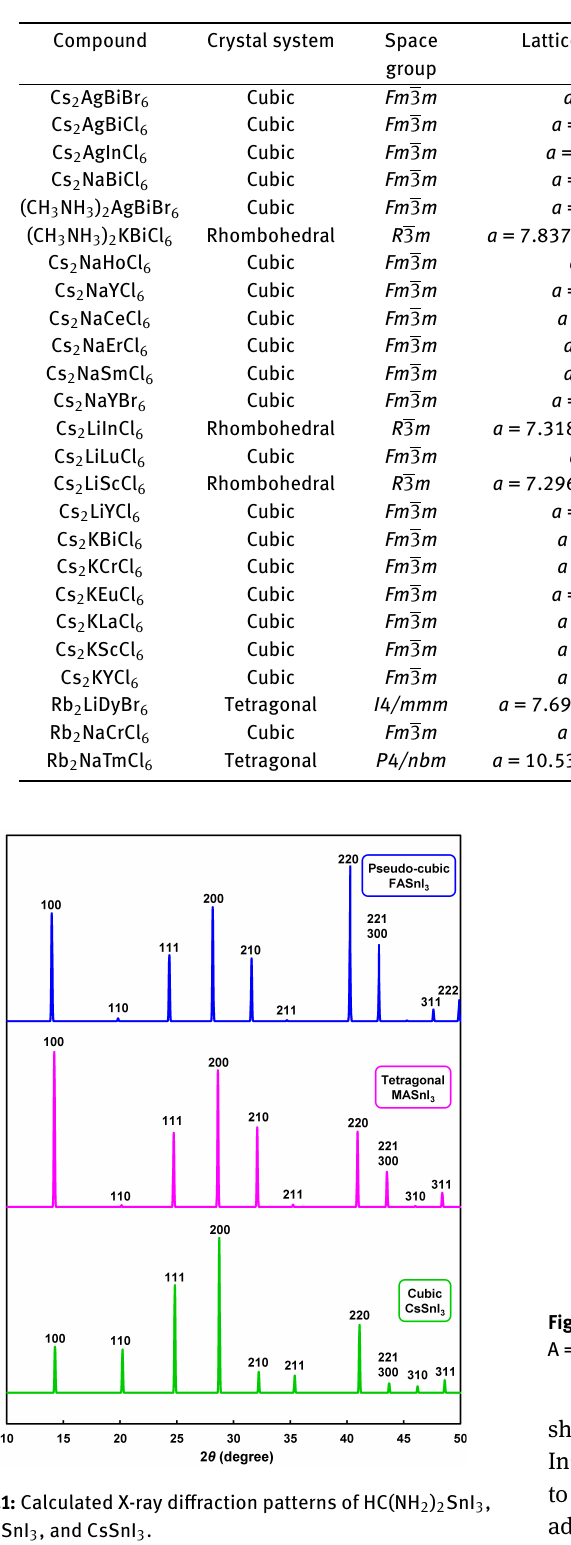
Table 12: Crystal systems of various double perovskite halide compounds.